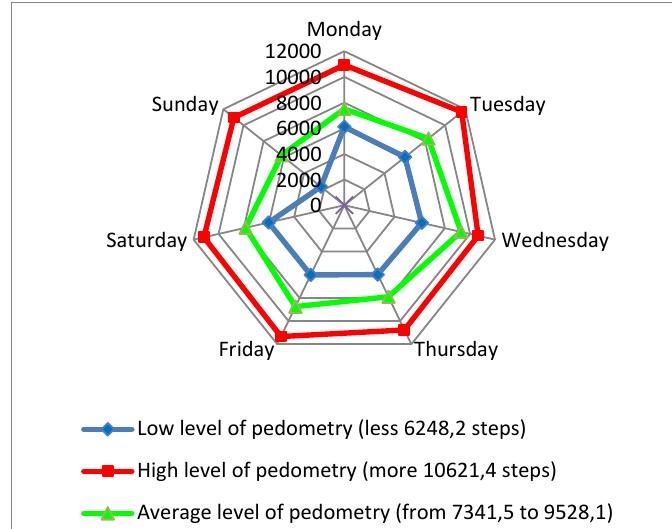
Figure 3. Distribution of the number of steps in females per day of the week